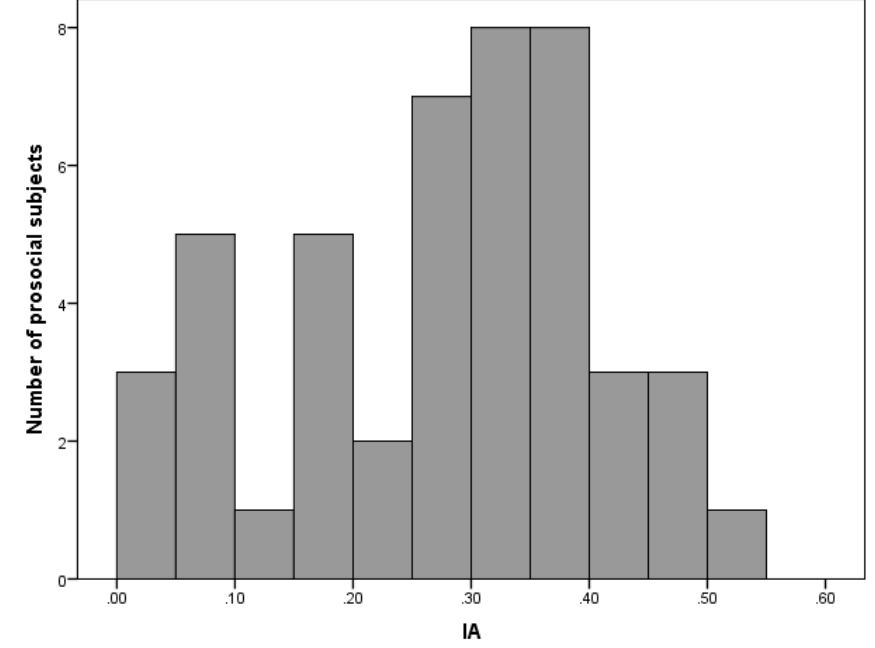
Figure 1. Number of participants displaying prosocial preferences from inequality aversion (0) to joint gain maximization (1).